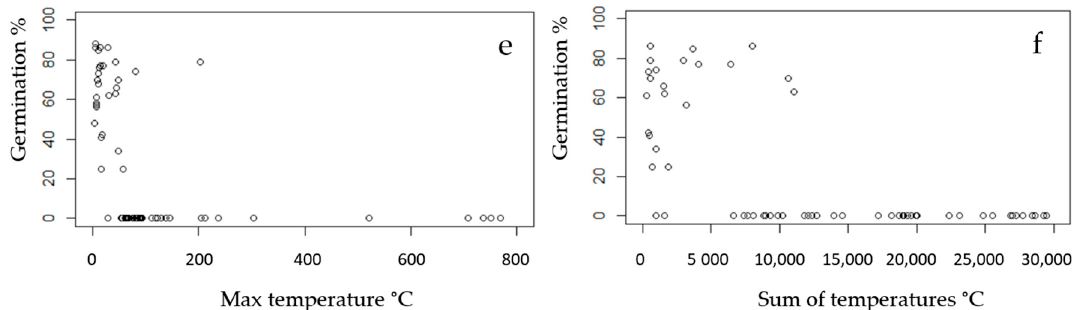
Figure 4. Plot of germination percentage in relation to maximum temperature measured during the burning period, and plot of germination percentage in relation to sum of temperatures based on temperature records every 30 s measure during the burning period for mugo pine ( a , b ), lodgepole pine ( c , d ), and Sitka spruce ( e , f ), respectively.